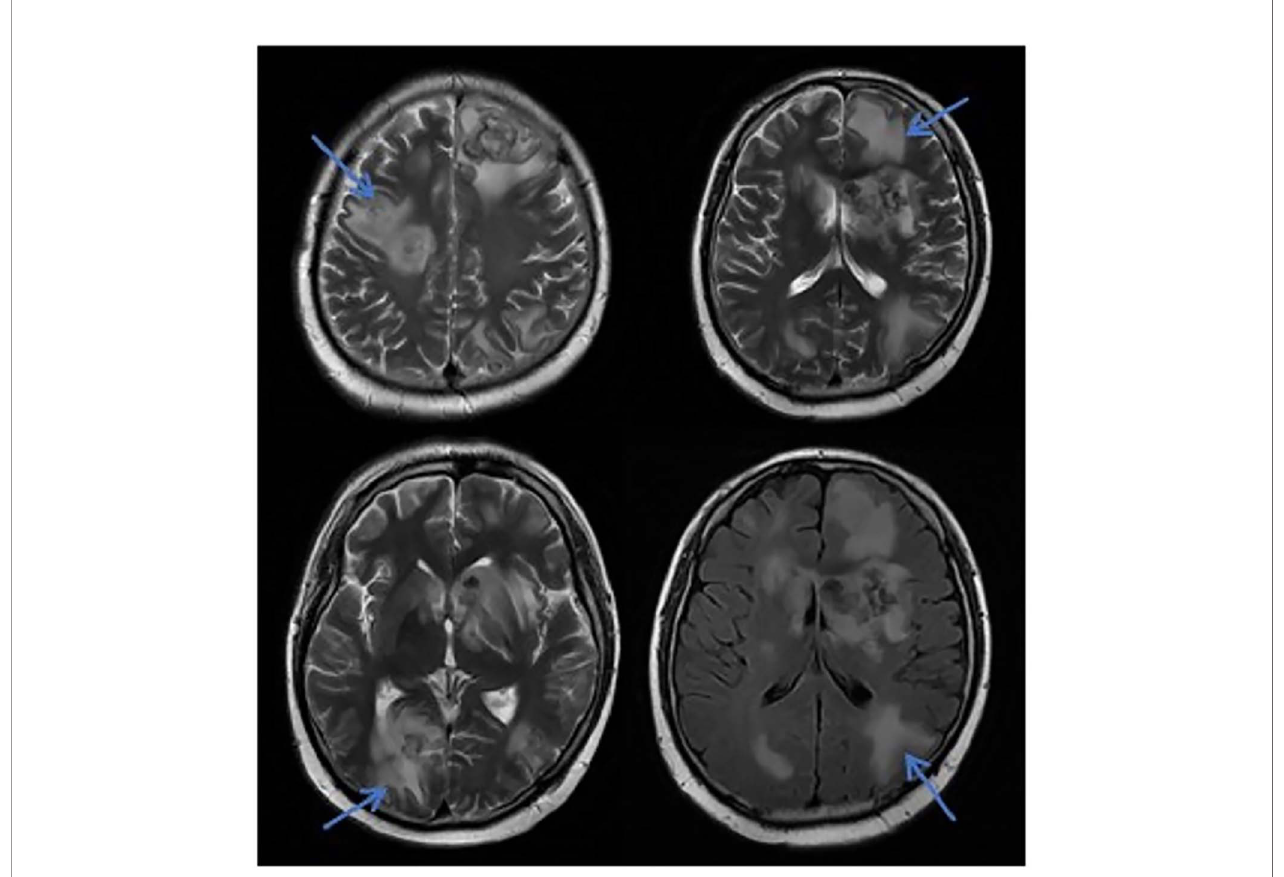
FIGURE 4 | MRI in patients with CNS leukemia and infection. Primary central nervous system in fi ltration MRI indicated that the lesion showed mixed signals on the T1WI and nodules with mixed signals on the T2WI and T2WI fl air. A DWI spot-like hyperintensity was observed in the lesion, and the